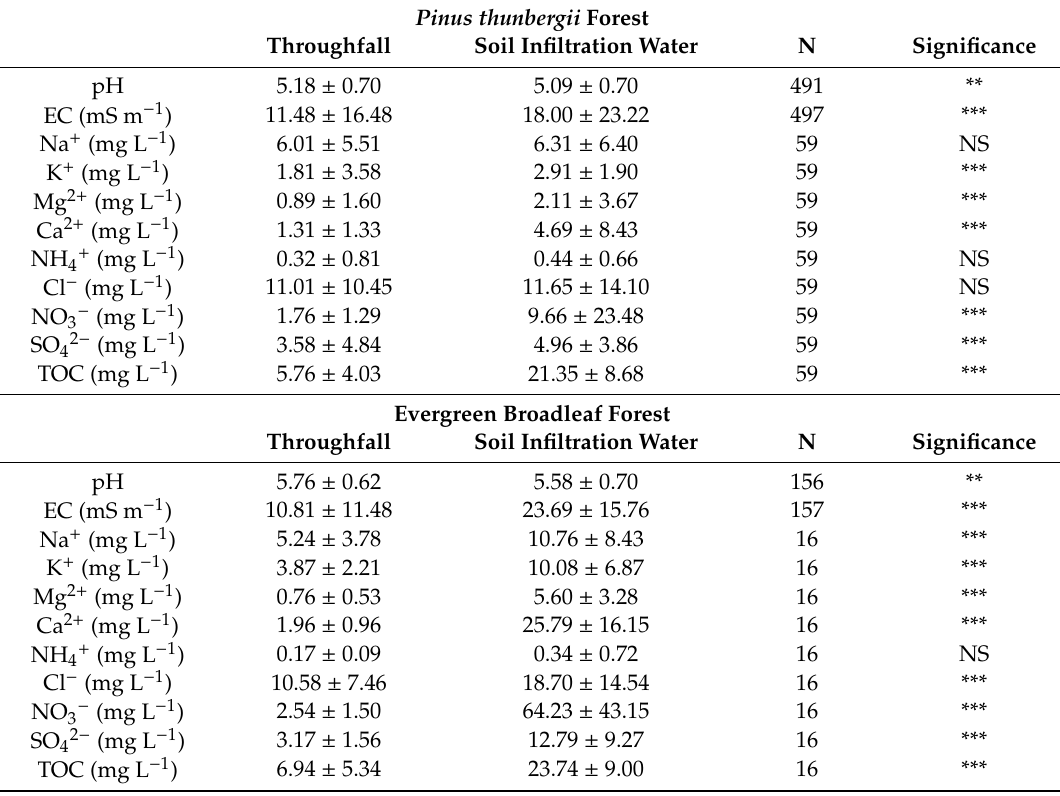
Table 2. Chemical variables of throughfall and soil infiltration water in the Sanri-Matsubara